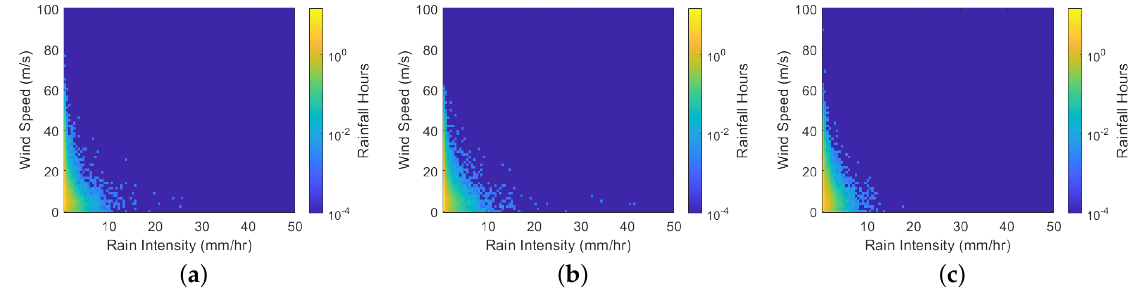
Figure 27. Frequency distribution of wind vs. rain data for the months of June ( a ), July ( b ) and December ( c